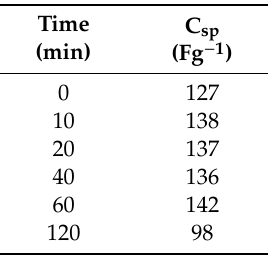
Table 3. Gravimetric specific capacitance of hybrid PAni-ACC composites as a function of the electropolymerization